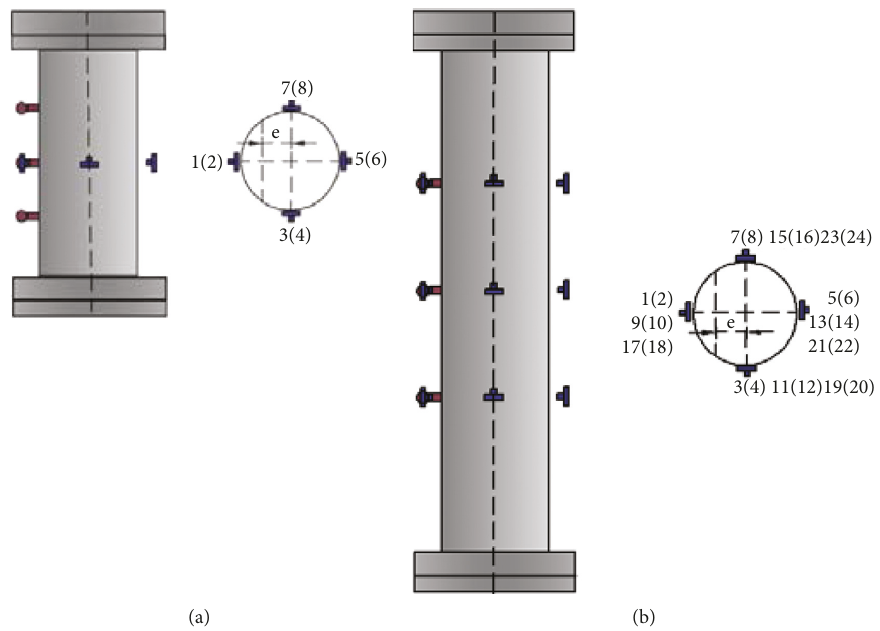
Figure 2: Strain arrangement: (a) short column; (b) long column.